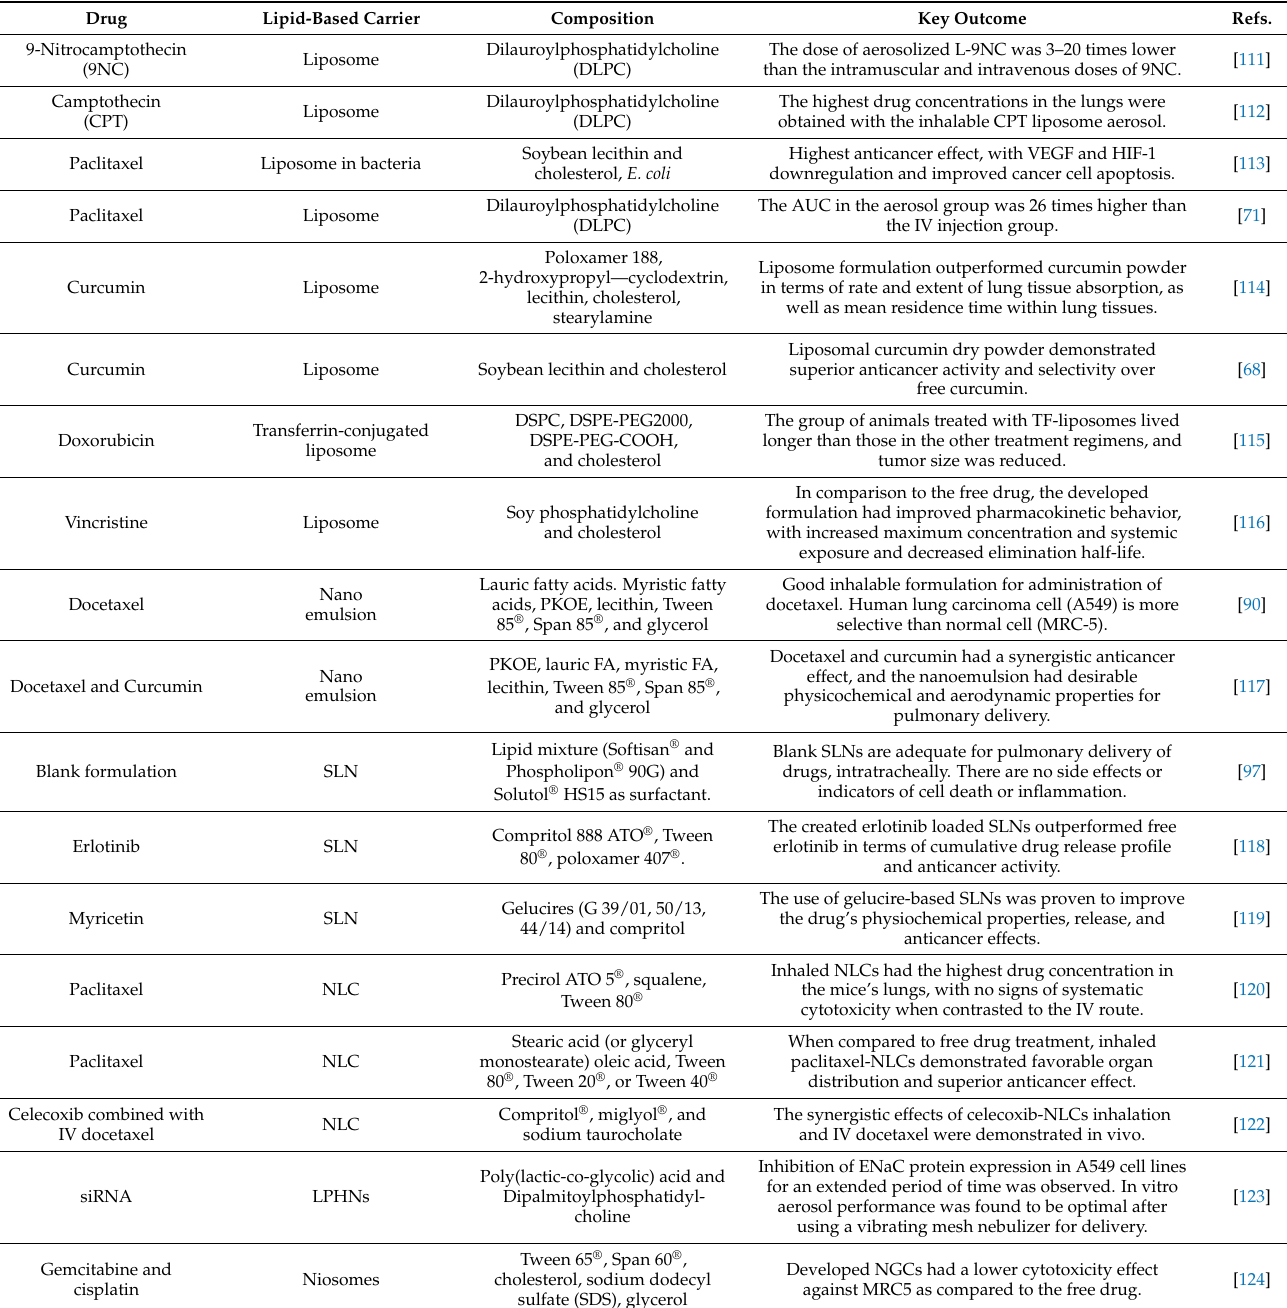
Table 2. Inhalable lipid nanocarriers for drug delivery against